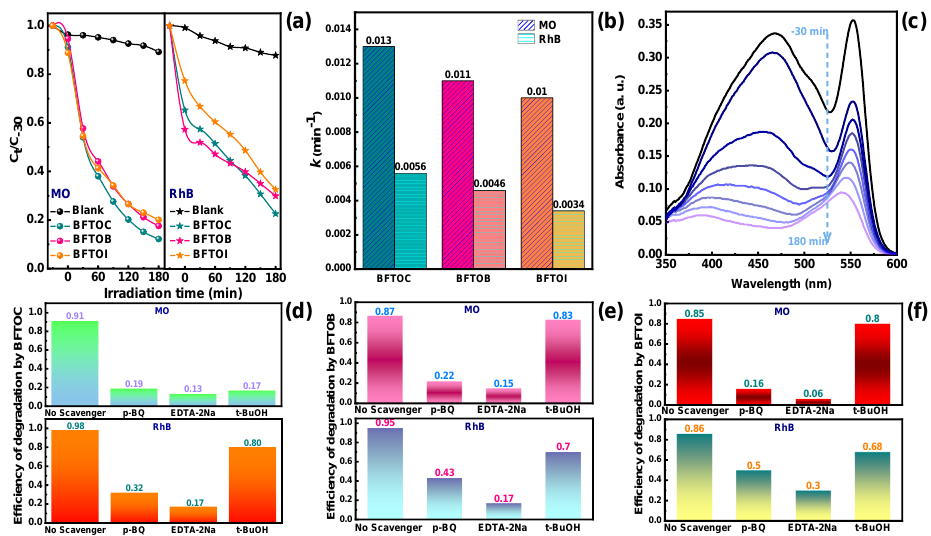
Figure 7. ( a ) The photocatalytic MO and RhB degradation activities over BFTOX. ( b ) The corresponding k values from kinetic linear fitting curves. ( c ) Degradation of the mixture of MO and RhB as a function of irradiation time. Degradation rate of MO/RhB over ( d ) BFTOC, ( e ) BFTOB, and ( f ) BFTOI with the addition of p − BQ, EDTA − 2Na and TBA.